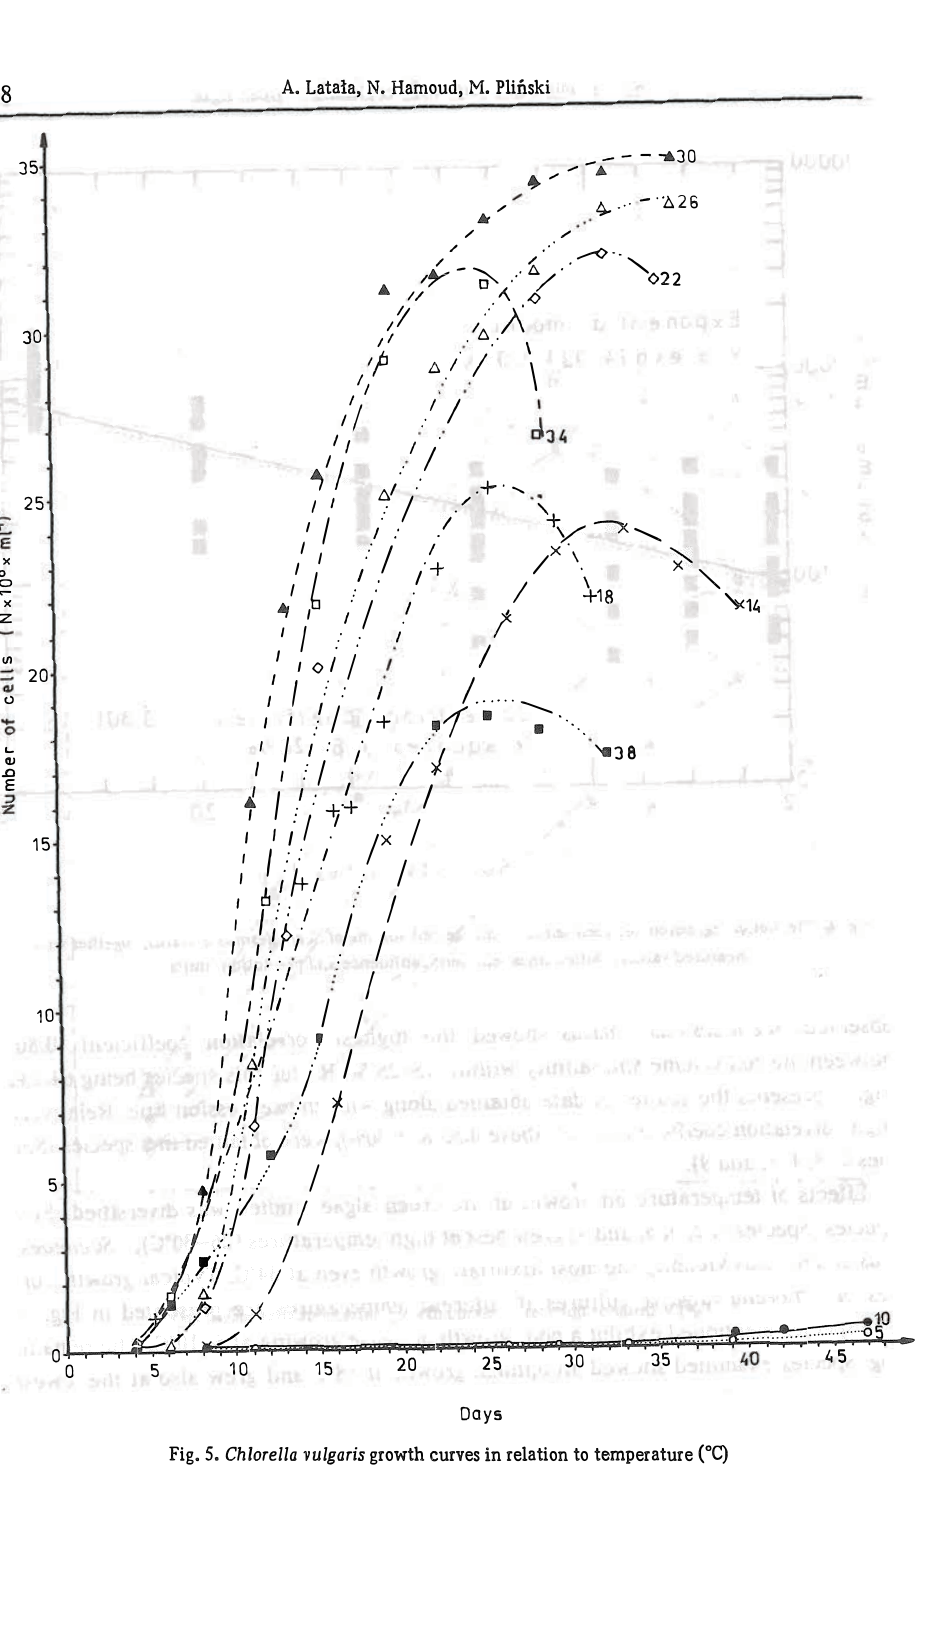
Fig. 5. Chiarella vulgaris growth curves in relation to temperature ( 0